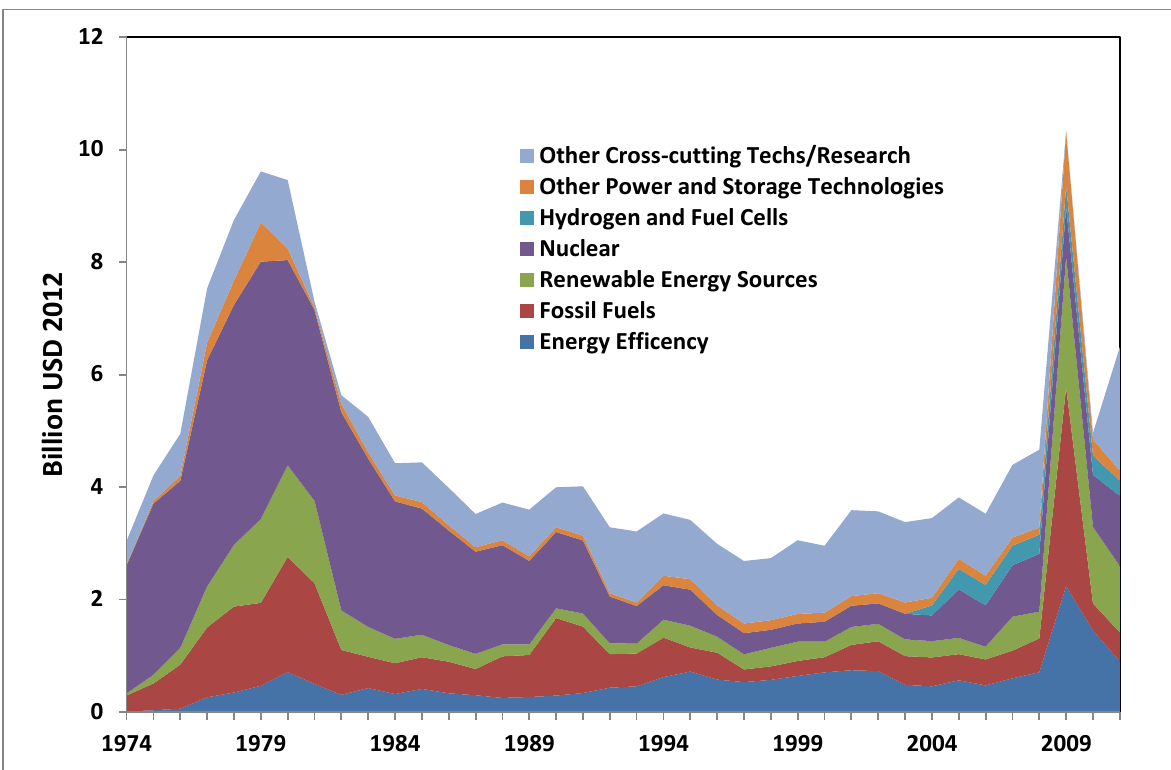
Figure 8. Historic Public Energy Spend by Sector for the US 1974–2011